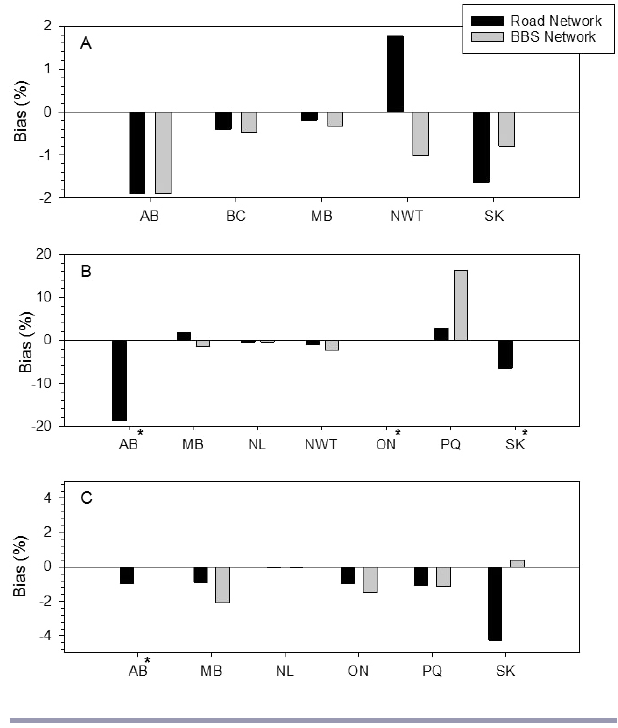
Fig. 3 . Overall bias in representation of forest “loss” along North American Breeding Bird Survey (BBS) routes compared with the proportion of forest loss (2000-2012) in BBS strata within the full BBS network and the road network as a whole in (A) bird conservation area 6 (BCR 6; Boreal Plains), (B) BCR 7 (Taiga Shield and Hudson Plains), and (C) BCR 8 (Boreal Softwood Shield). An asterisk (*) indicates that missing BBS network bars are because of no BBS coverage within the associated stratum and not zero values.